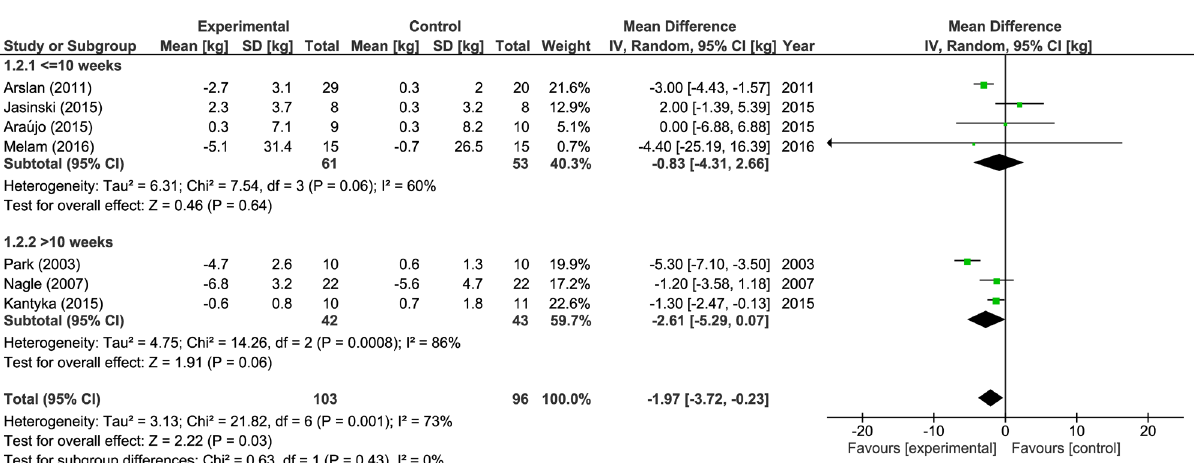
Figure 4. Assessment of the effect of aerobics on body weight depending on duration of